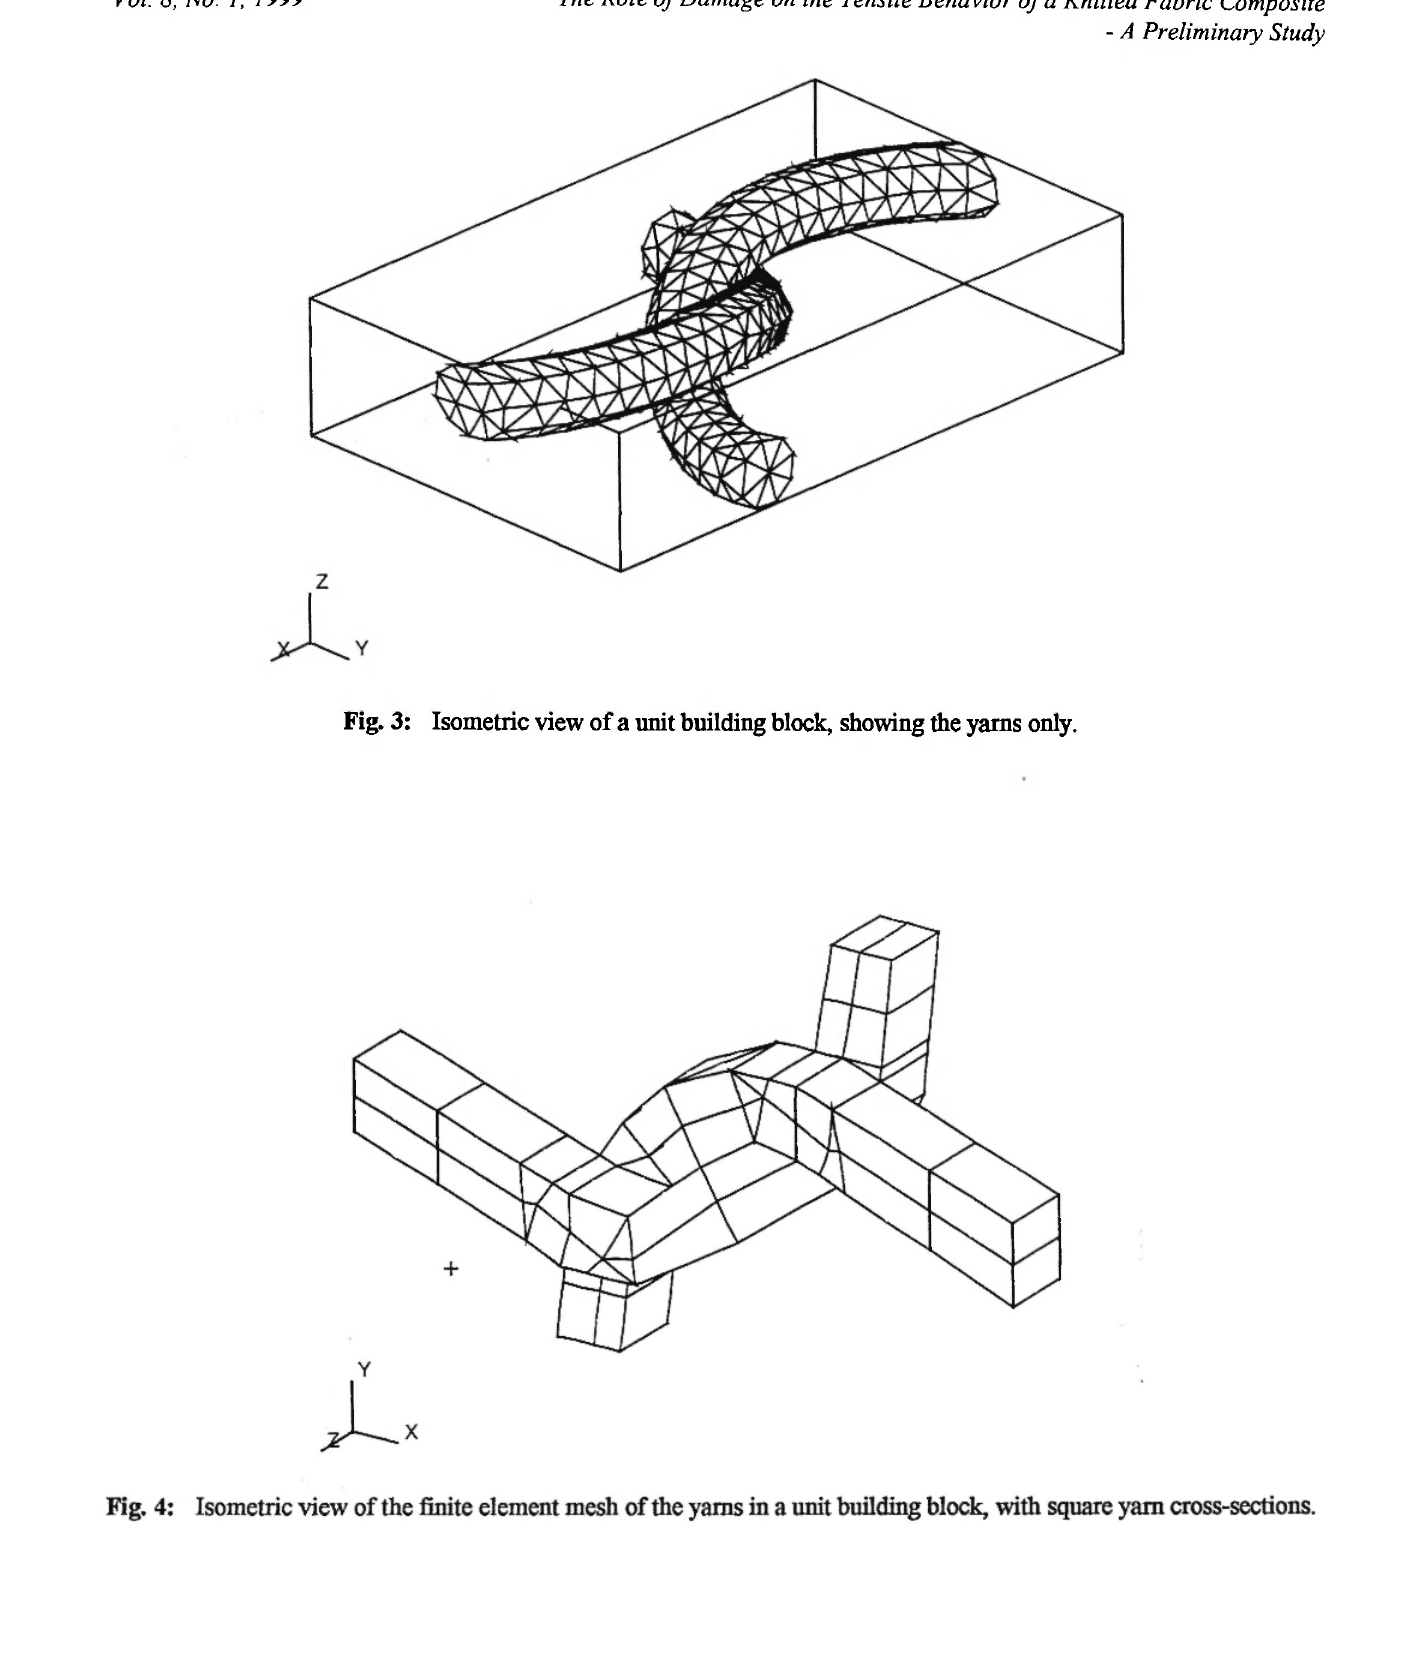
Fig. 3: Isometric view of a unit building block, showing the yarns